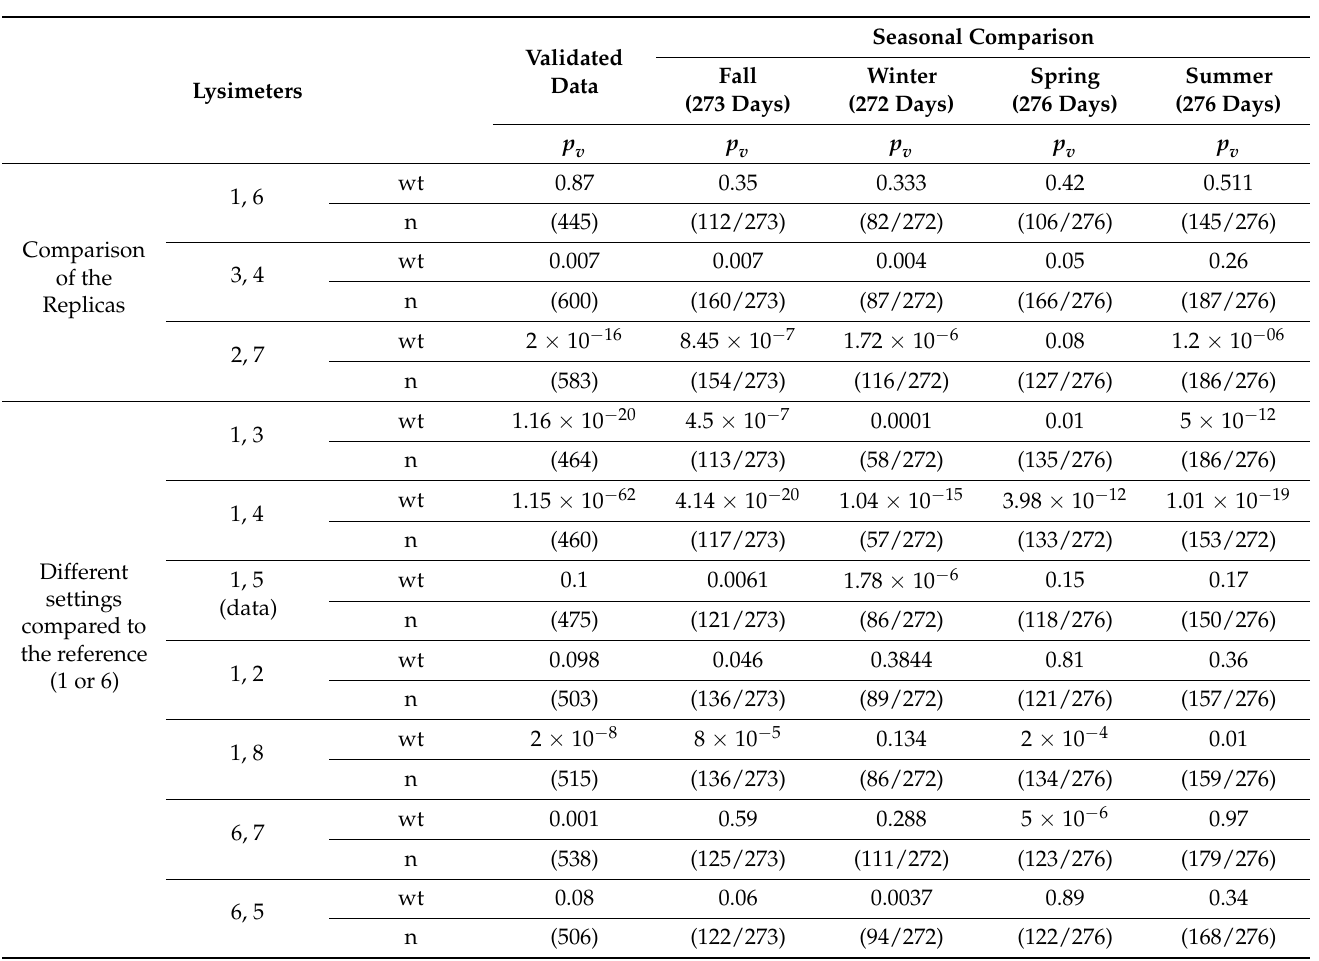
Table A2. A Wilcoxon test (wt) results comparing lysimeters replicas and different configurations to the reference one the lysimeter 1. The test is performed based on the whole validated data and seasons. For the seasons, it is considered fall (22 September to 21 December), winter (21 December